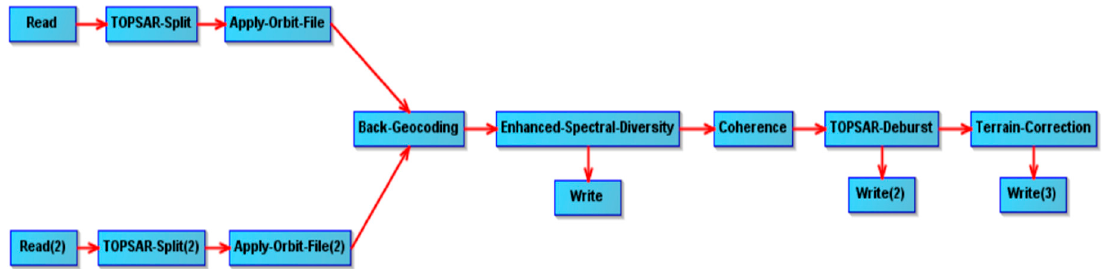
Figure 8. Coherence maps development methodology. The workflow was created in the Graph Builder tool in Sentinel’s Application Platform (SNAP) software.